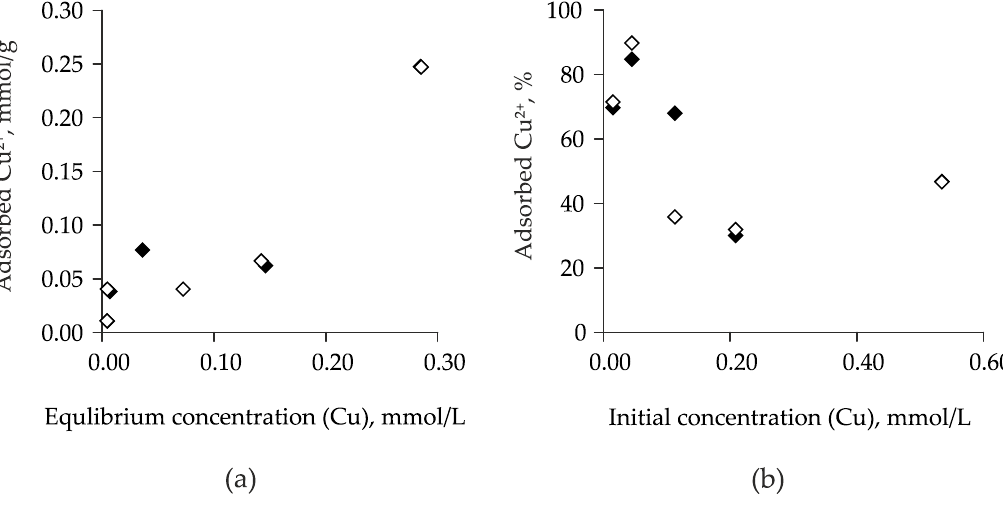
Figure 9. The sorption isotherm ( a ) and the fraction of the adsorbed Cu 2+ ion ( b ) on the Al 13 -bentonite HA ( 1 , 2 ). Empty and filled icons—repetitions of an experiment.